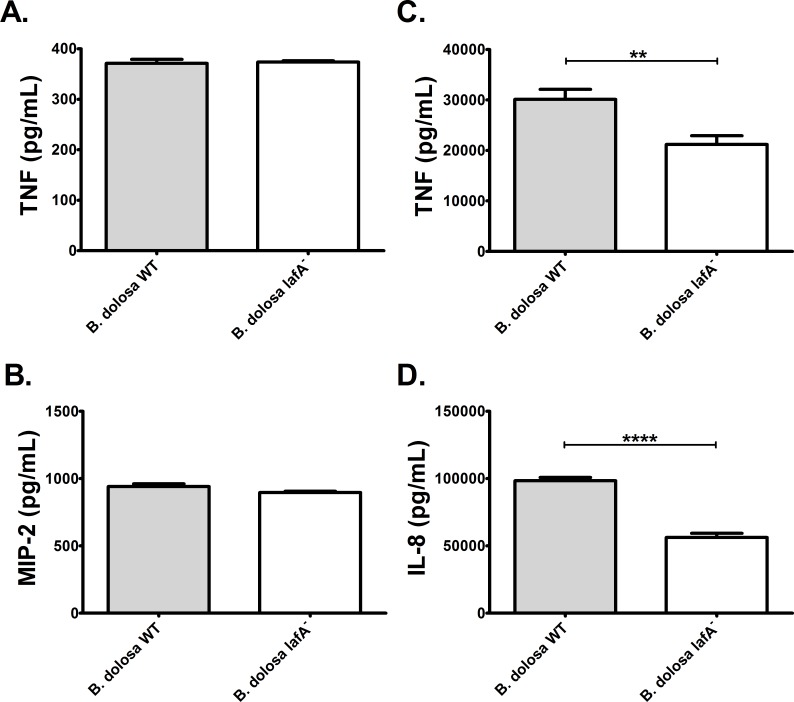
In vitro cytokine response from human and mouse cells.B. dolosa AU0158 wild-type and lafA deletion mutant were added at an M.O.I. of 10 to RAW264.7 murine macrophages to (panels A and B) or human PBMCs (panels C and D). The production of TNF or IL-8/MIP-2 was assayed for each strain from replicate samples. Medium alone negative controls were near or below the limit of detection (N.D.) for all panels. Error bars represent one standard deviation of the data. Asterisks correspond to p-values of <0.01 (**) or <0.0001 (****) based on unpaired t-tests.